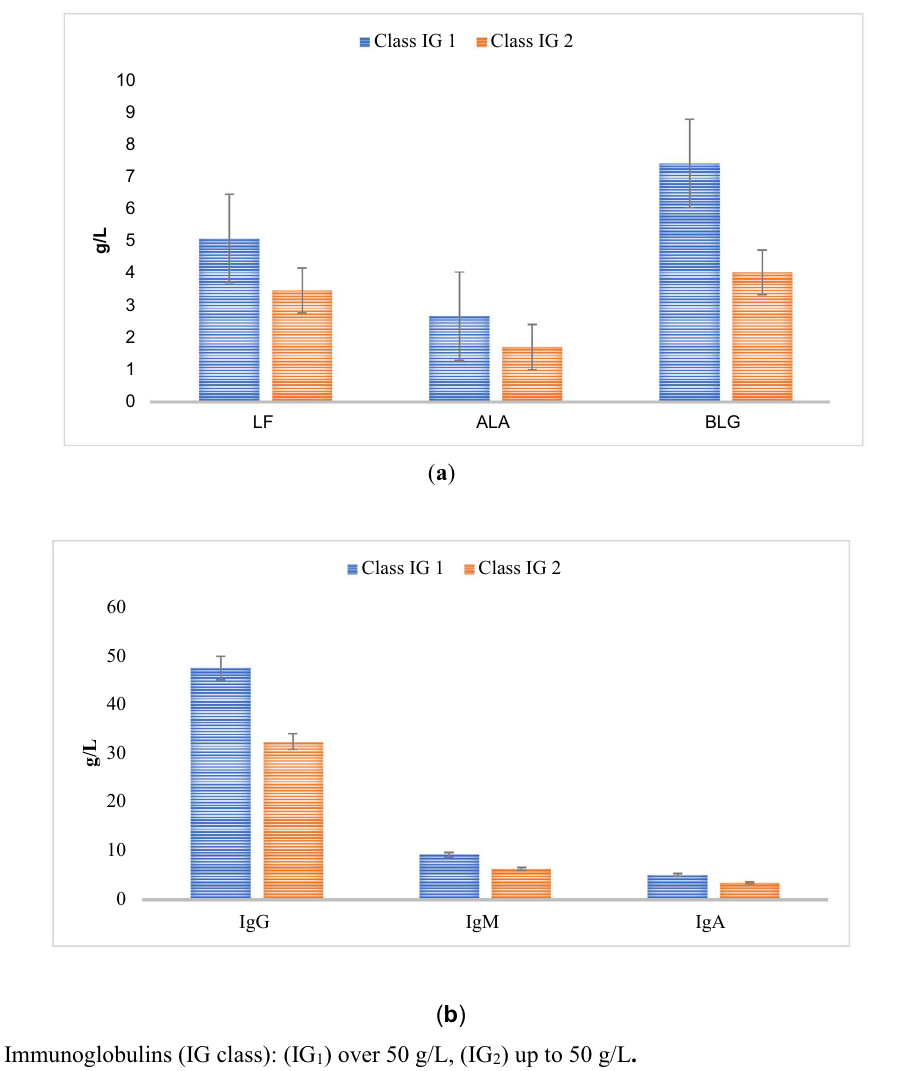
Immunoglobulins (IG class): (IG 1 ) over 50 g/L, (IG 2 ) up to 50 g/L .